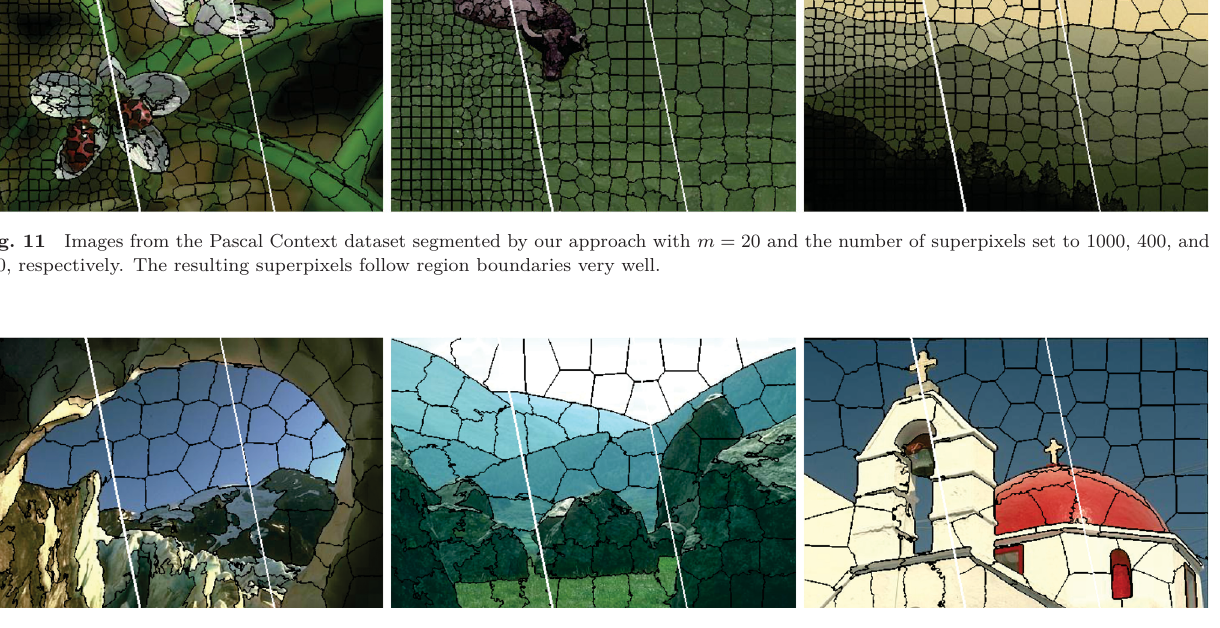
Fig. 12 Images from the BSDS dataset segmented by our proposed approach with m = 10, 20, and 30, respectively. When m is smaller, the superpixels follow boundaries well. When m is larger, the superpixels are more compact.